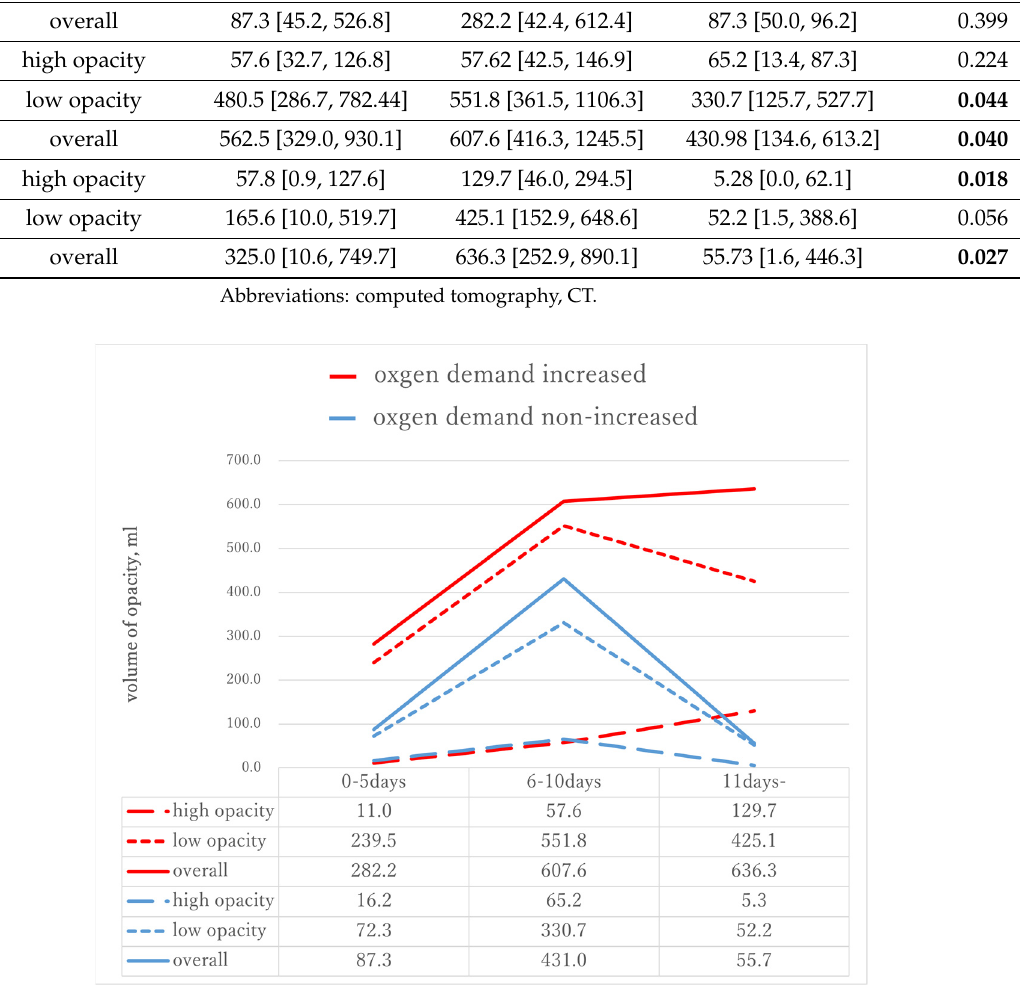
Figure 3. Change in the volume of each type of opacity on the chest CT from the time of the initial onset of symptoms. The low opacity volume peaked during the middle period and decreased during the late period for both the increased oxygen demand and the nonincreasing oxygen demand groups. Conversely, the high opacity volume increased during the late period for the increased oxygen demand group but decreased for the nonincreased oxygen demand group.